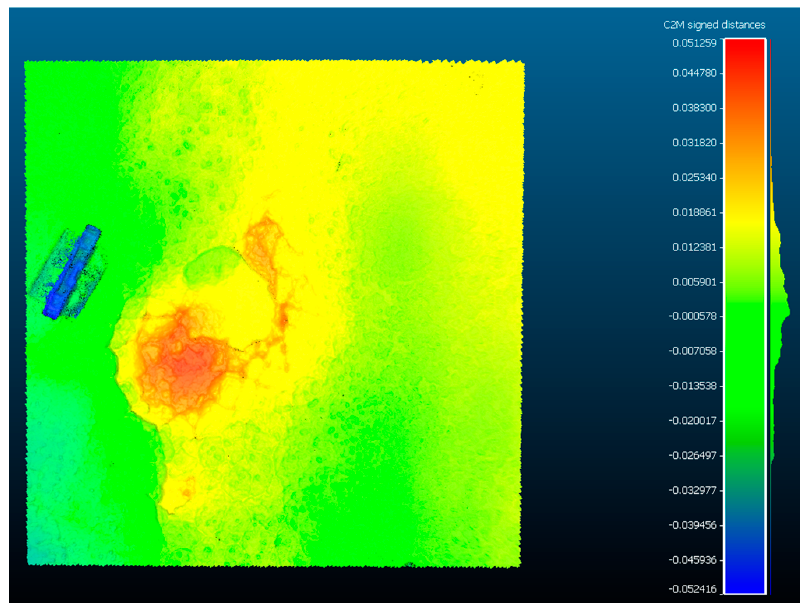
Figure 23. Pavement section 2 with the depth map created.